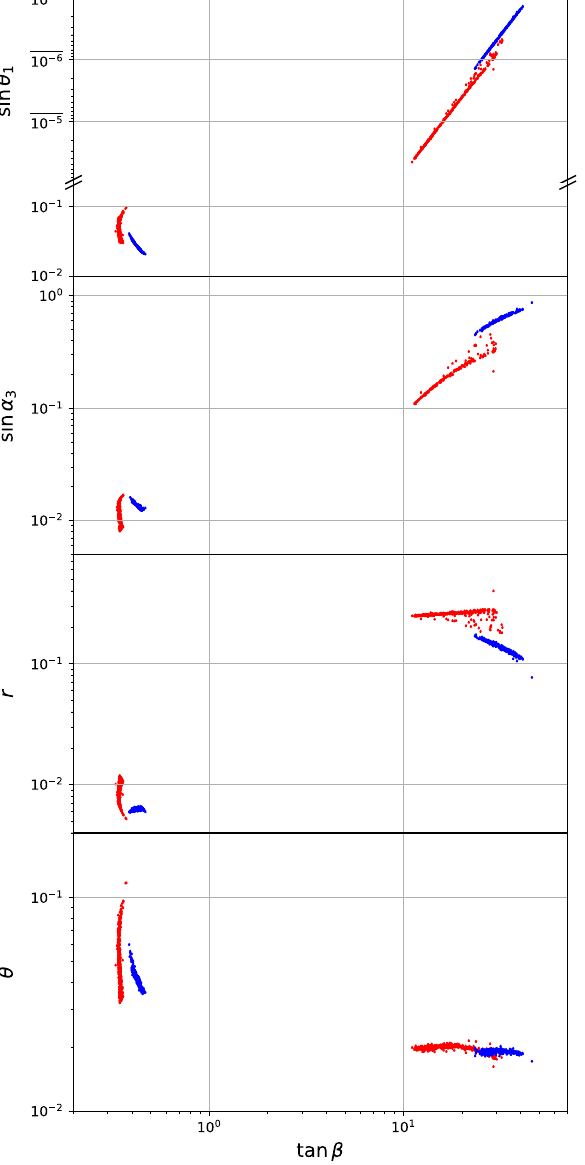
(cid:18) < 0 . 13 m ν i